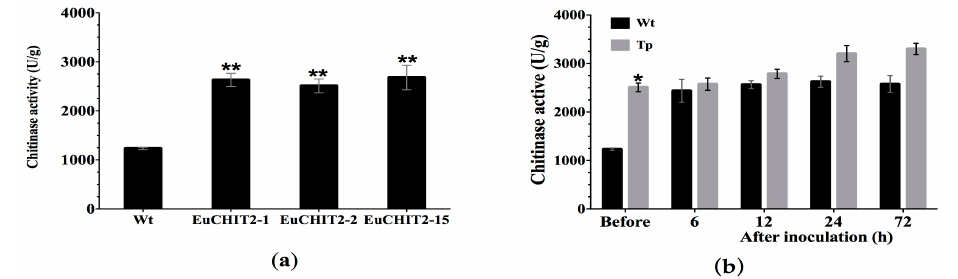
Figure 3. Chitinase activities of wild-type and transgenic tobacco plants challenged with E. cichoracearum de Candolle. ( a ) Chitinase activities in uninoculatie plant ( p < 0.01); ( b ) chitinase activities of T1 EuCHIT2 transgenic lines before inoculation and 6, 12, 24, and 72 h after inoculation with E. cichoracearum DC. Wt, wild-type, ( n = 3); Tp, transgenic plant (EuCHIT2-15), ( n = 3). Error bars indicate standard error (SE); * and ** indicate significant differences at p < 0.05 and p < 0.01, respectively.